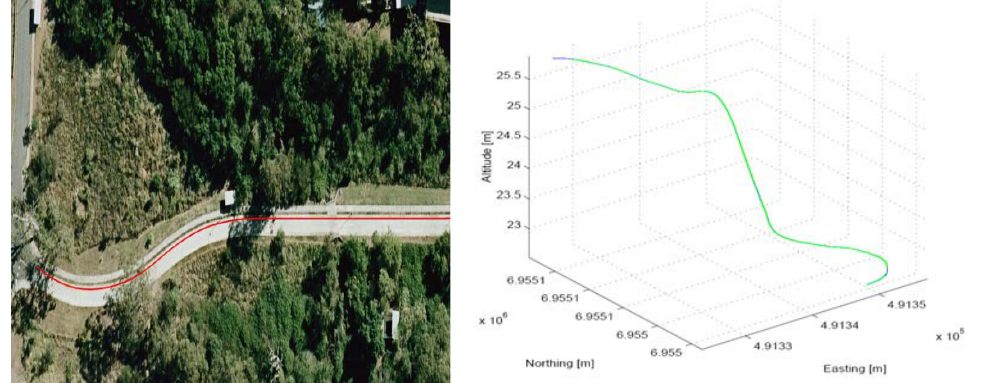
Figure 4. Test track view and 3D plot.